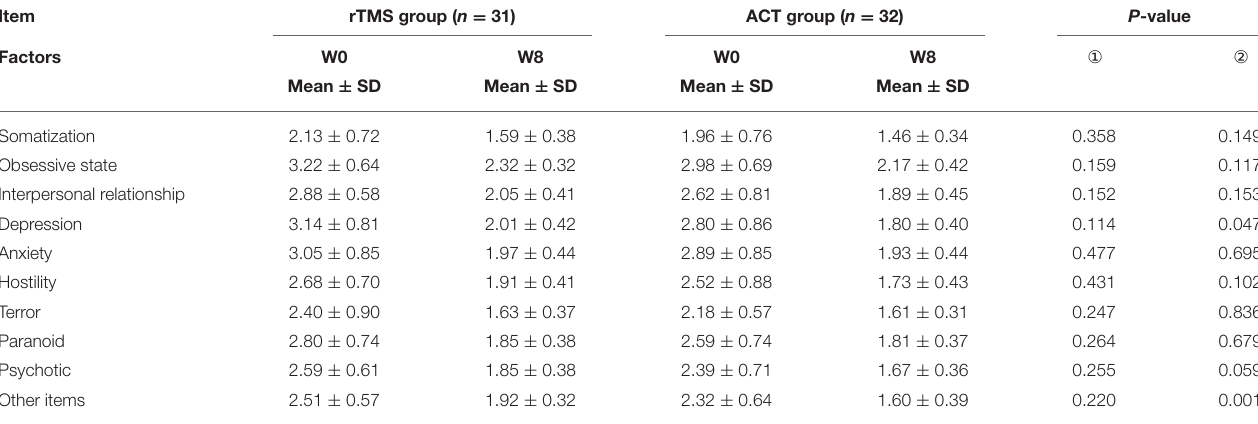
TABLE 2 | Comparison of SCL-90 between the rTMS and the ACT groups.